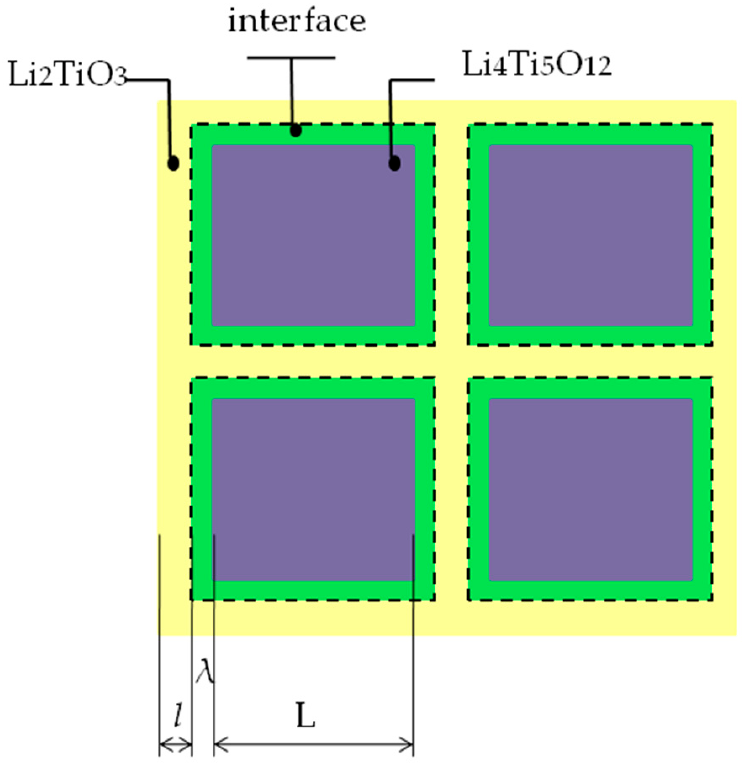
Figure 8. A simplified model of the LTO-Li 2 TiO 3